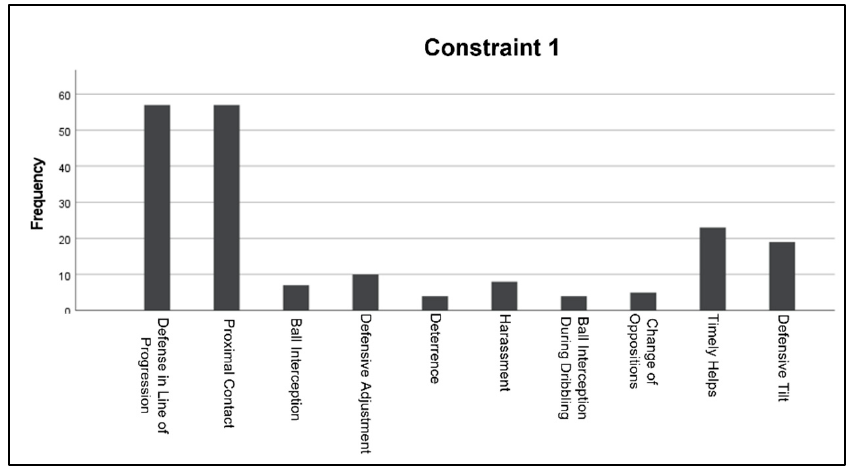
Figure 2. The frequency in which handball’s motor behaviors were activated during the exercise where constraint 1 (All Attackers with one ball) was applied.